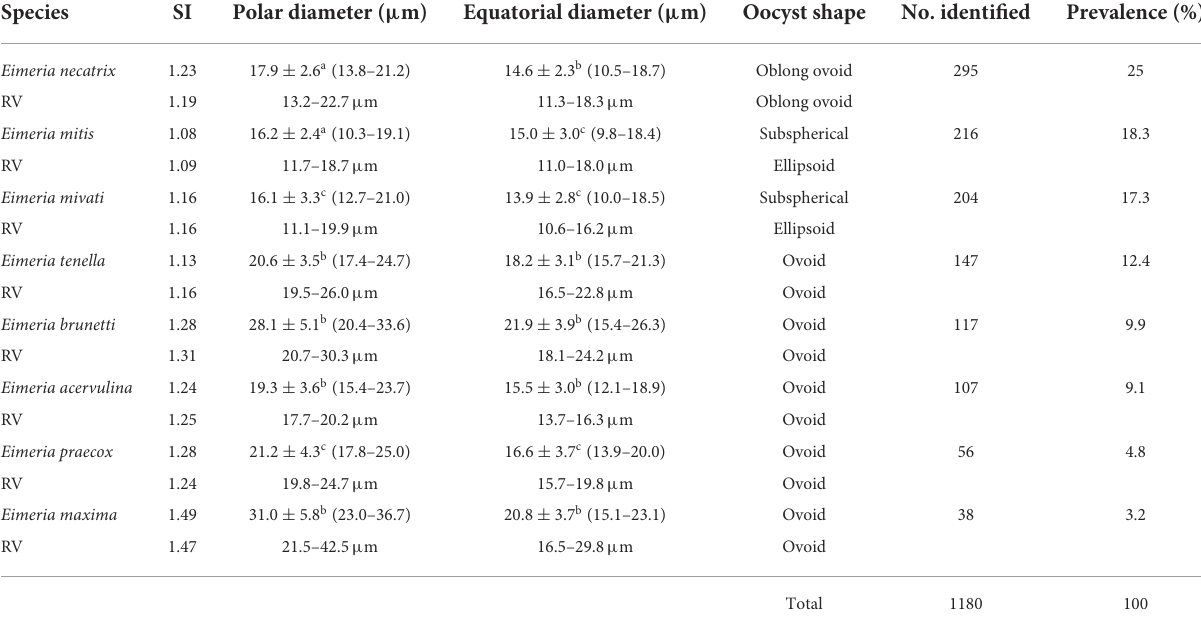
TABLE 1 Morphometric values of oocysts from free-range chickens that were obtained in the Sertão region of the state of Paraiba, northeastern Brazil. Species SI Polar diameter ( µ m) Equatorial diameter ( µ m) Oocyst shape No. identified Prevalence (%)